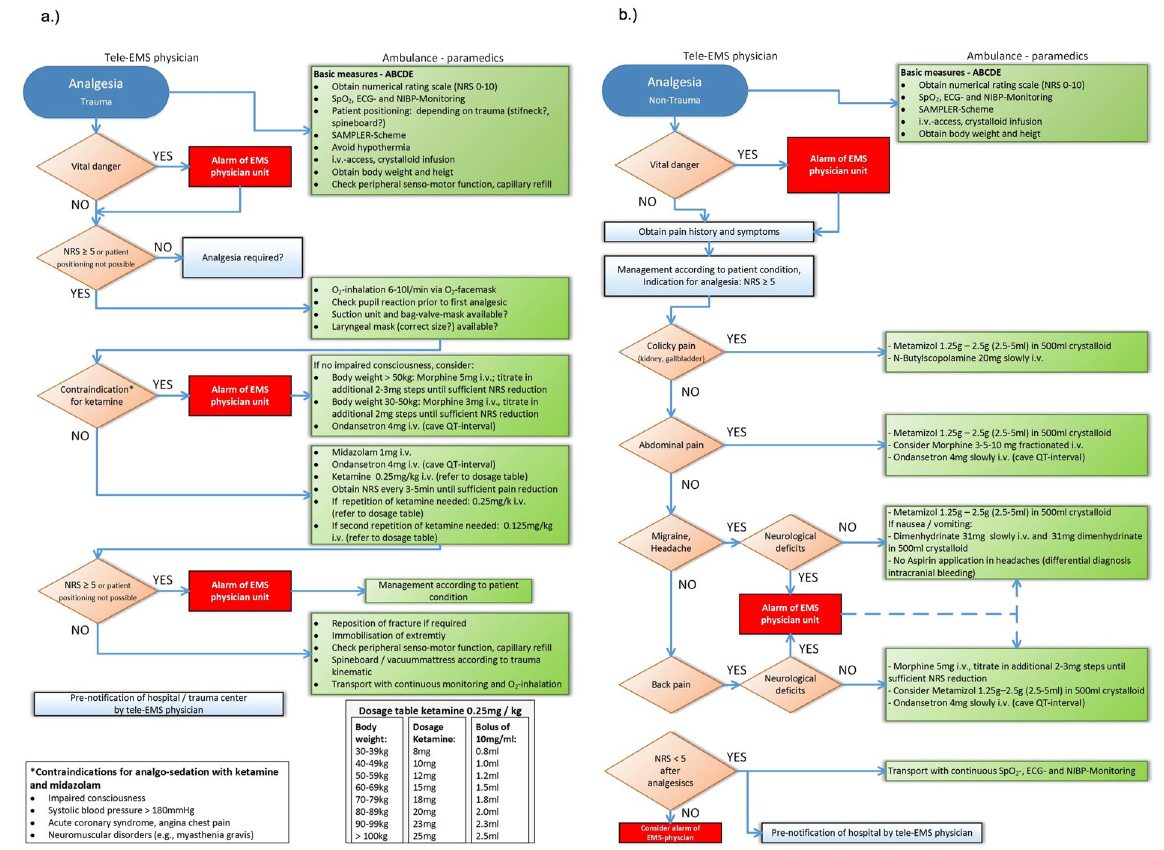
Figure 1. Standard operating procedure (SOP) for analgesia in teleconsultation: ( a ) trauma, ( b )